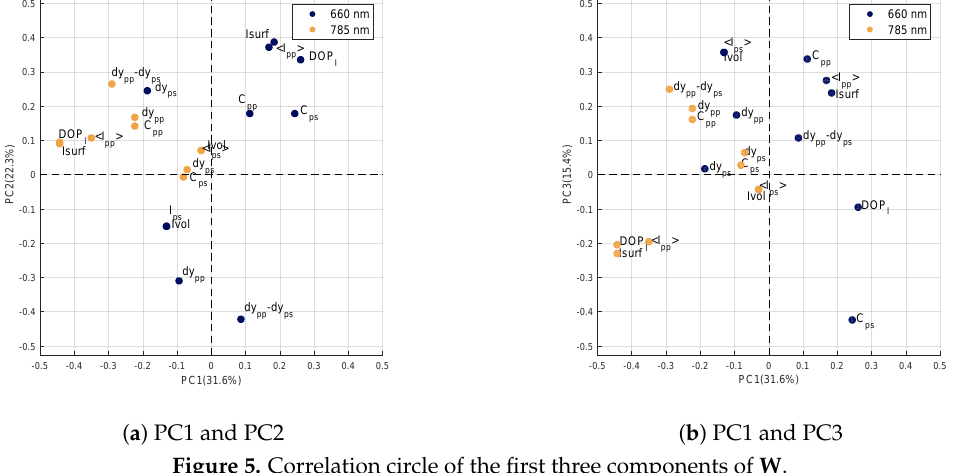
Figure 5. Correlation circle of the first three components of W